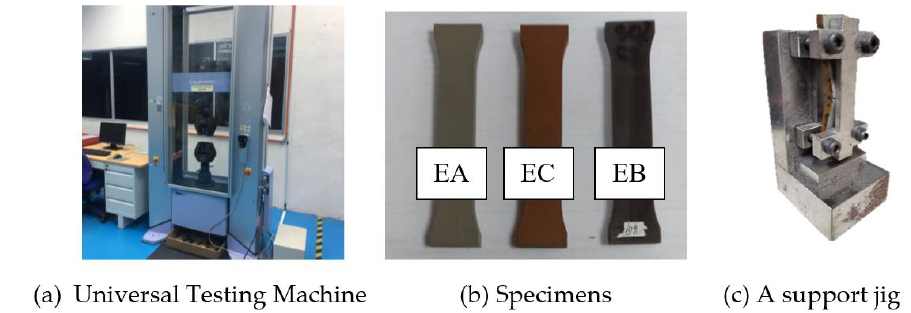
Figure 9. Compression